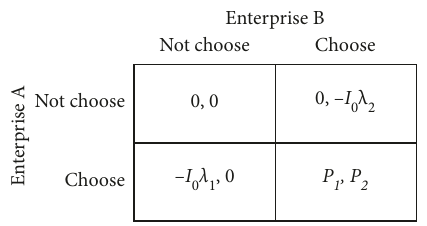
Figure 5: Dynamic game return matrix of